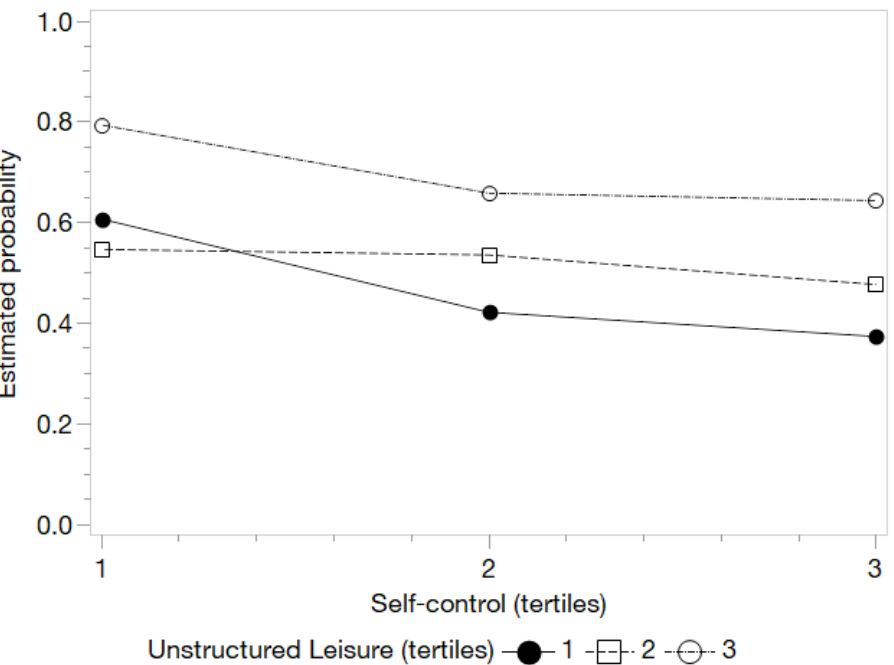
Figure 1. Estimated probabilities for the interaction between self-control and unstructured leisure for the YAU in the Netherlands.